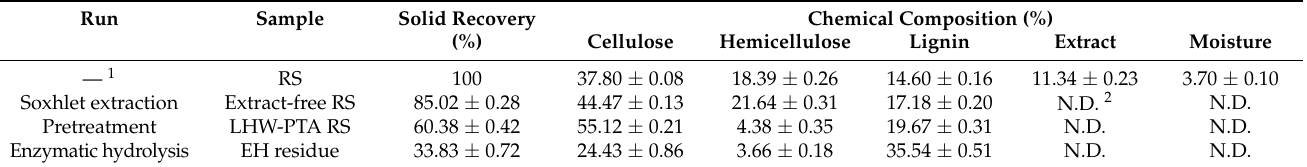
Table 1. The chemical composition of rice straw before and after the absolute ethanol extraction, pretreatment, and enzymatic